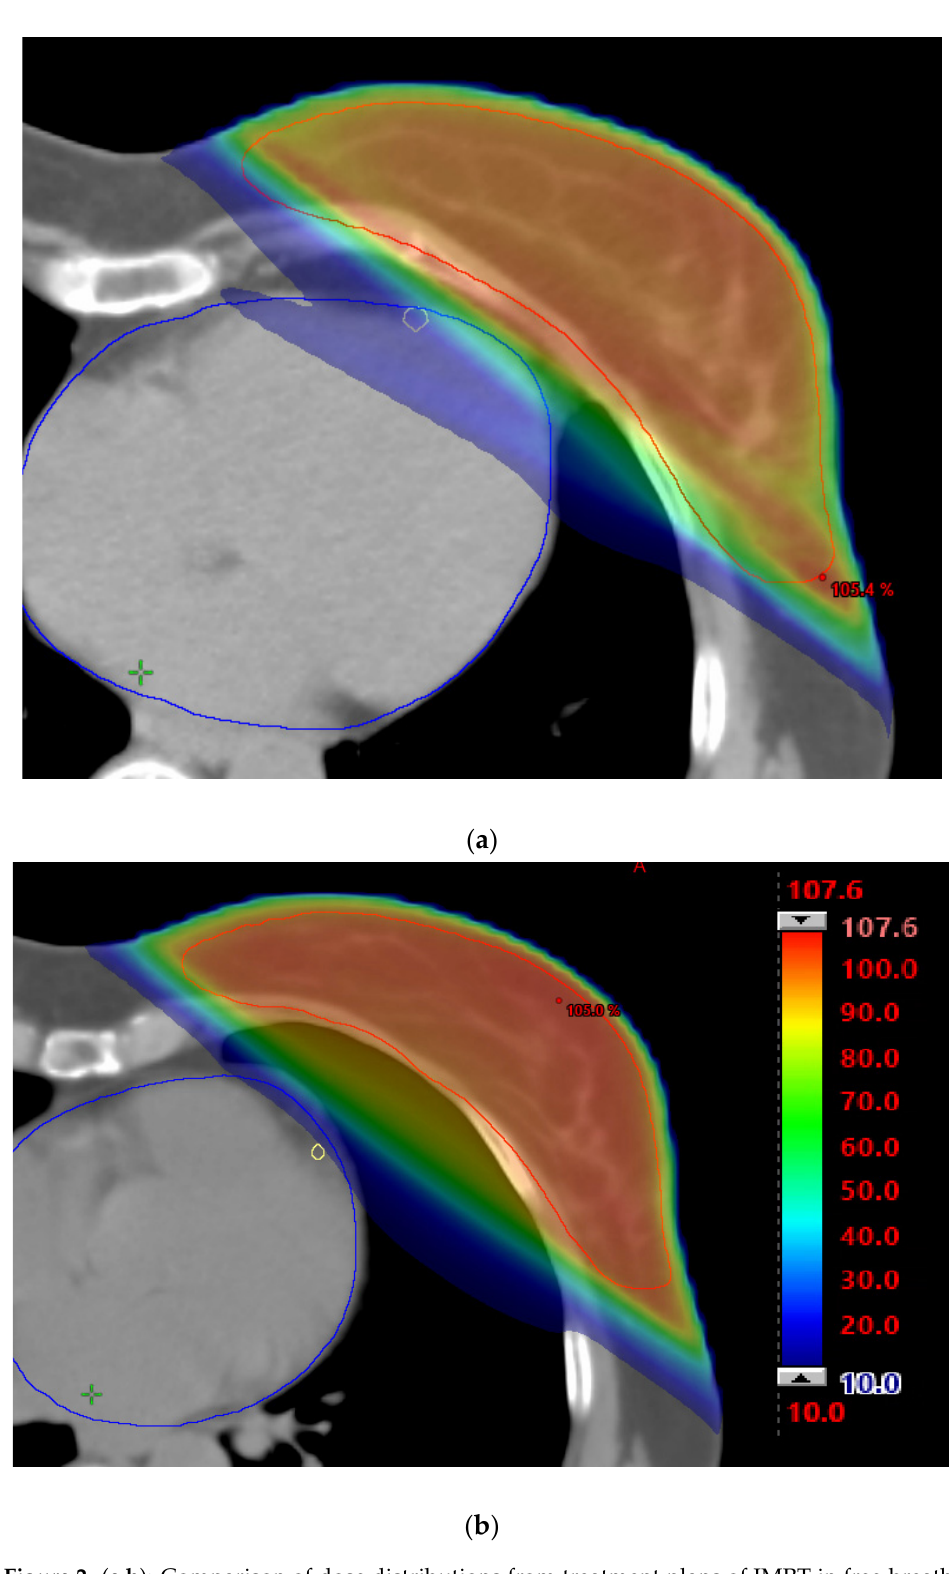
Figure 2. ( a , b ): Comparison of dose distributions from treatment plans of IMRT in free-breathing ( a ) and DIBH ( b ) planning scans of the same patient, where the increase in distance of the treated breast from the cardiovascular structures in the DIBH plan, resulted in reduced dose to the heart and LAD. The dose distributions are shown in colour-wash mode, which scale is in ( b